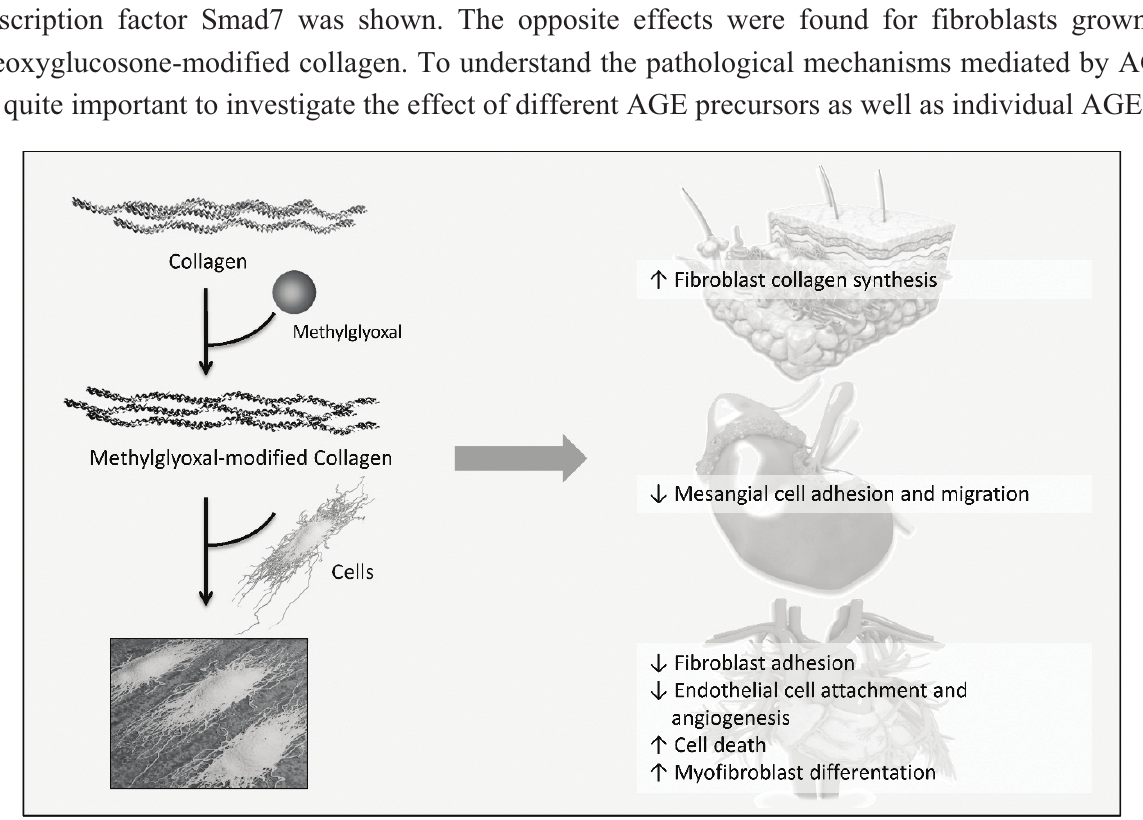
Figure 5. Influence of methylglyoxal-modified collagen on cellular functions relevant to diabetic complications, according to [113,116,119,120]. Cells were cultured on methylglyoxal-modified collagen and the effect of AGE-collagen on cellular functions was studied. Dermal fibroblasts grown on modified collagen increase collagen synthesis. Methylglyoxal-modified collagen reduces cell adhesion and migration of mesangial cells, cardiac fibroblast are less adherent. Myofibroblast differentiation is stimulated in cardiac fibroblasts cultured on modified collagen and modifications of basement membrane collagen causes detachment, cell death and reduced angiogenesis of vascular endothelial